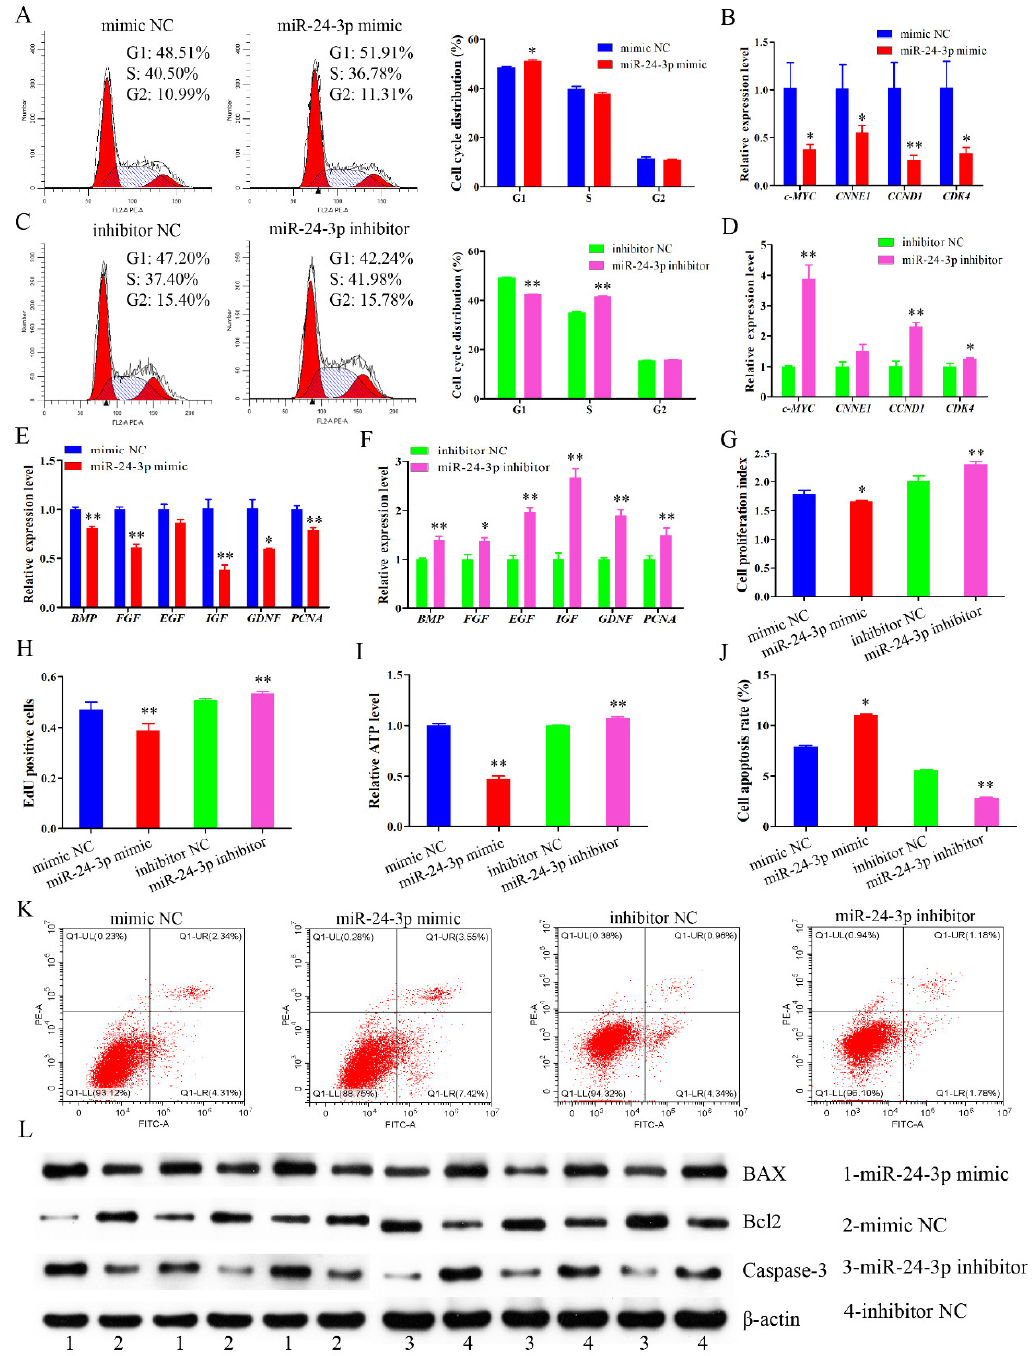
Figure 4. miR-24-3p impeded proliferation and induces apoptosis of immature porcine Sertoli cells. Immature porcine Sertoli cells were transfected with miR-24-3p mimic, mimic NC, miR-24-3p inhibitor, or inhibitor NC. ( A , C ) The cell cycle analysis of cells with miR-24-3p overexpression ( A ) or inhibition ( C ) ( n = 3). ( B , D ) qRT-PCR assay measured the effect of miR-24-3p overexpression ( B ) or inhibition ( D ) on the mRNA expression of cell cycle-related genes ( n = 3). ( E , F ) The mRNA expression of cell proliferation marker genes was illustrated in miR-24-3p mimic ( E ) or inhibitor ( F ) transfected cells ( n = 3). ( G , H ) The effect of miR-24-3p overexpression or inhibition on cell proliferation was checked using the CCK-8 ( G ) and EdU ( H ) incorporation assays ( n = 3). ( I ) The relative ATP level was investigated in 24-3p mimic or inhibitor transfected cells ( n = 3). ( J , K ) Cell apoptosis rate was determined by Annexin V-FITC/PI staining followed by flow cytometry ( n = 3). The cell apoptosis rate was counted in each cell transfection group, and representative images are listed. ( L ) The protein expression of cell survival-related genes was determined in miR-24-3p mimic or inhibitor transfected cells using Western blot assay ( n = 3). Data are presented as the mean ± S.D. * p < 0.05, ** p < 0.01.